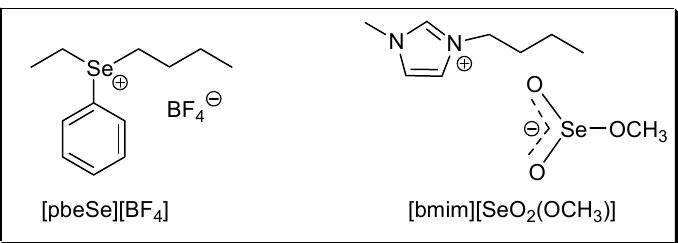
Figure 1. Structures of the selenium-based ionic